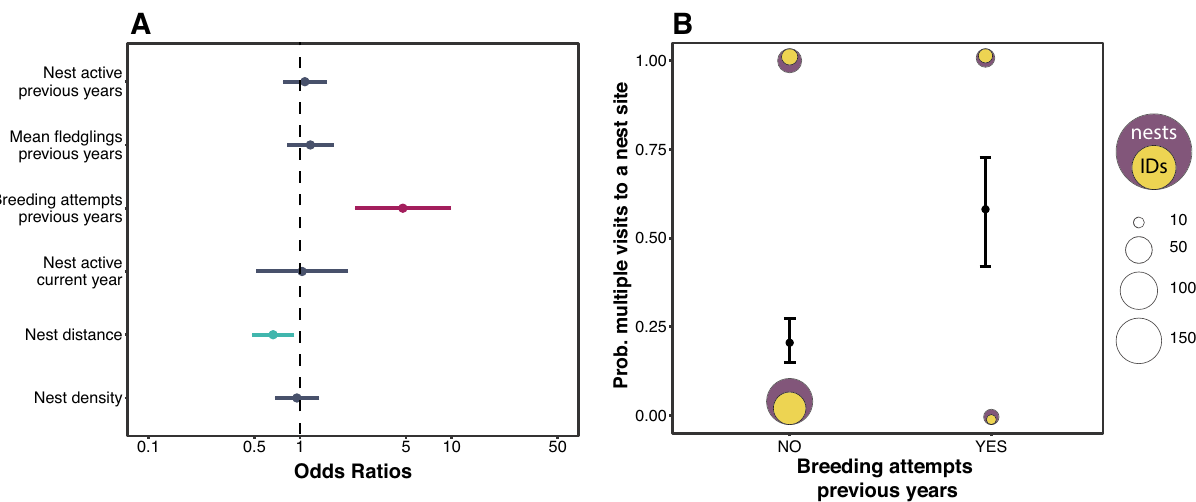
Figure 3. Binomial GLM summary of the results (estimated coefficient with 95% confidence interval ranges) on the probability of revisiting a nest site one or multiple times, dark blue represent standardised effects with 95% C.I. overlapping zero, light purple and light blue represent positive and negative effects, respectively, with 95% C.I. not overlapping zero ( A ). Predicted effect (estimate with 95% confidence intervals) of the predictor with strong evidence of a positive effect given by breeding attempts in the revisited nest in previous years ( B ). Purple dots are nests visited and their size is related to the number of visits per category, yellow dots represent the number of individuals involved. least one breeding attempt in the 15 years prior (Fig. 3B). In addition, the closer the nest boxes were, the more they were visited by the female owls (Fig. 3A). Other parameters concerning surrounding nest density, such as if the nest was currently occupied or not, how many times was occupied and mean fledged chicks in the previous 15 years were not found to affect the probability of multiple visits (Fig. 3A). Mean revisits predict probability of re-nesting. We found the mean visits per night was the best pros- pecting parameter predicting the probability of a second clutch (Fig. 4A) with ΔAIC c > 2 relative to the other univariate models (Table S11). We then included the mean visits per night in a more general binomial GLMM including brood size, age (of the female), home range size (of the male partner) and the proportion of fledglings relative to the number of eggs laid. From the global model we excluded the laying date since it is known to have